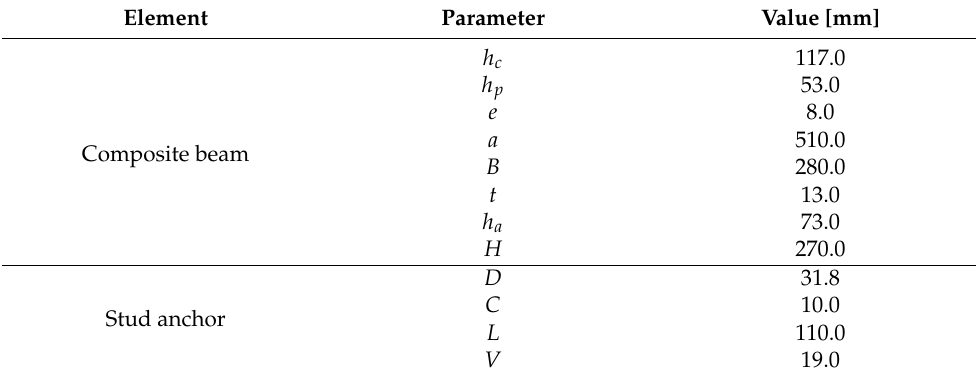
Table 1. Geometric parameters of composite beam and shear stud anchor.